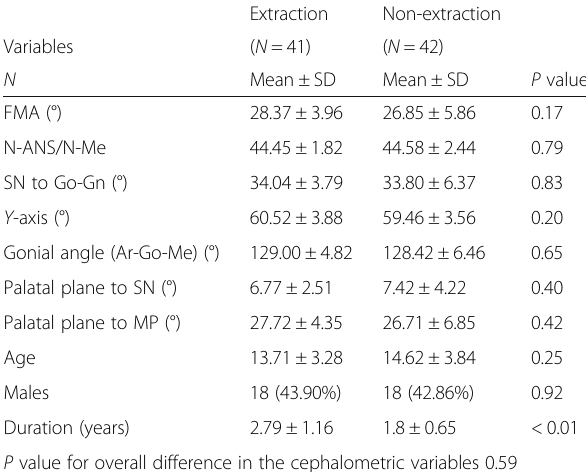
Table 1 Pretreatment differences between extraction and non- extraction groups with respect to demographic characteristics and cephalometric measurements Extraction